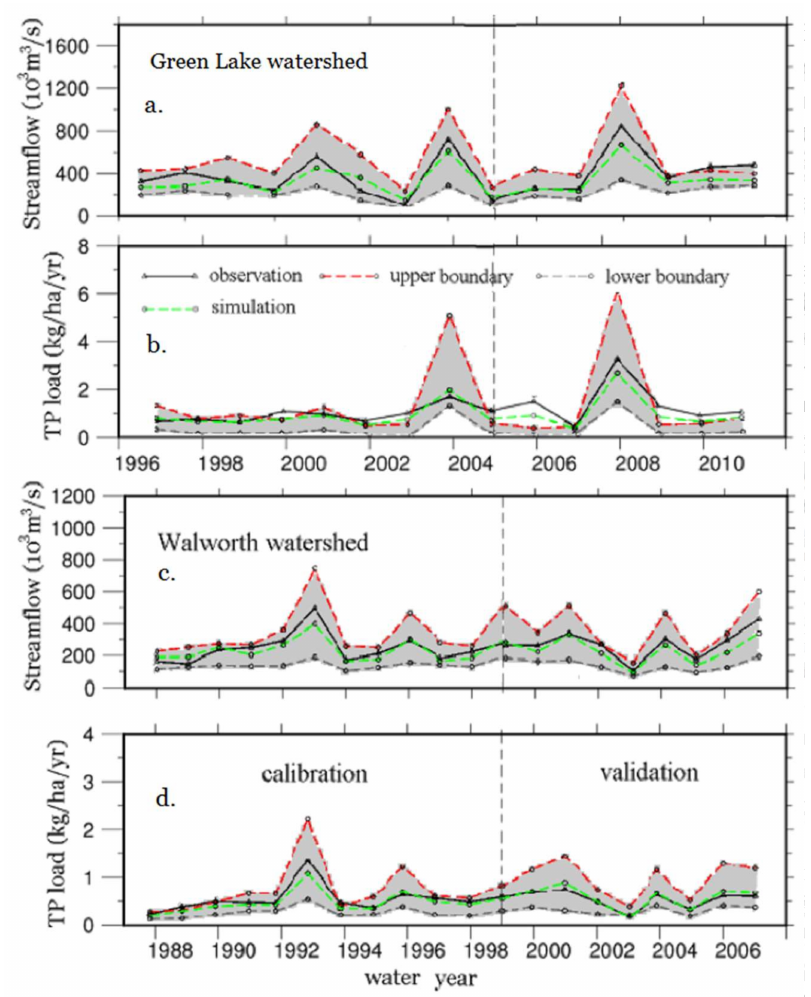
Figure 2. Parameter uncertainty of WEPP-WQ model in Walworth watershed and Green Lake watershed with the upper and lower boundaries. ( a ) streamflow of Green Lake watershed; ( b ) TP loss of Green Lake watershed; ( c ) streamflow of Walworth watershed; ( d ) TP losses of Walworth